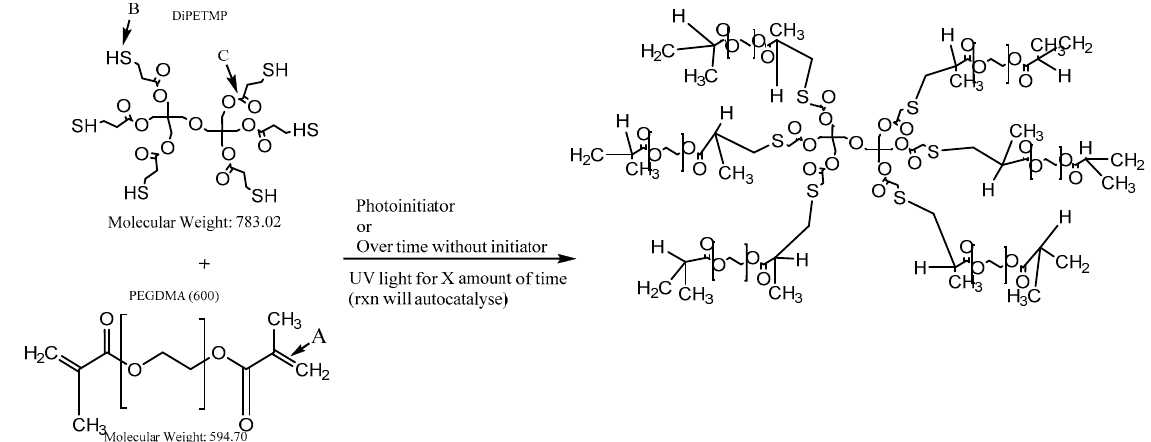
Figure 1. Photopolymerisation of polyethylene glycol dimethacrylate (PEGDMA) and dipentaerythritol hexa(3–mercaptopropionate) (DiPETMP); Arrows A and B respectively point to the reactive points for PEGDMA and DiPETMP; Arrow C points to one of the ester bonds that is broken during the hydrolytic degradation.